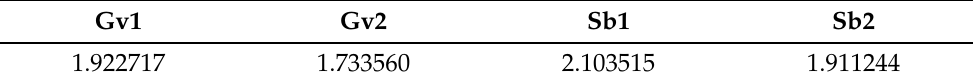
Table 1. Calibration factors obtained for the different microphones.